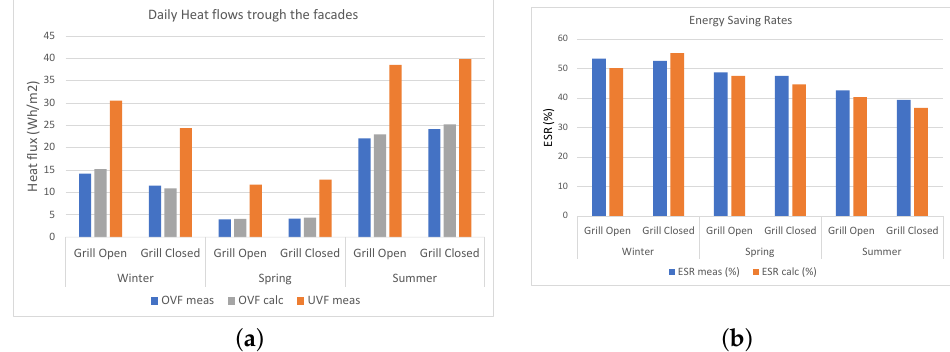
Figure 26. ( a ) Measured and calculated daily heat fluxes through the OVF vs. the UVF; ( b ) energy saving rates (%) measured and calculated. Table 8. Relative errors for heat fluxes and ESRs, measured vs. calculated. Winter Spring Summer Grid Grid Grid Grid Grid Grid Open Closed Open Closed Open Closed Heat Flux